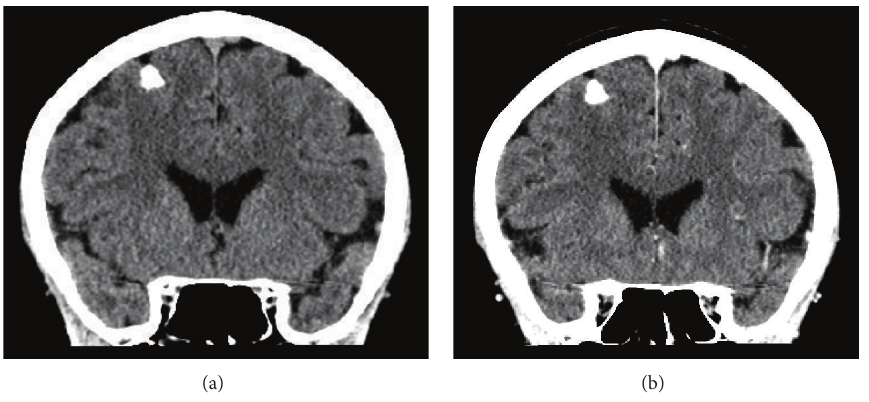
Figure 1: (a) 2013 precontrast CT coronal view. (b) 2013 postcontrast CT coronal view.